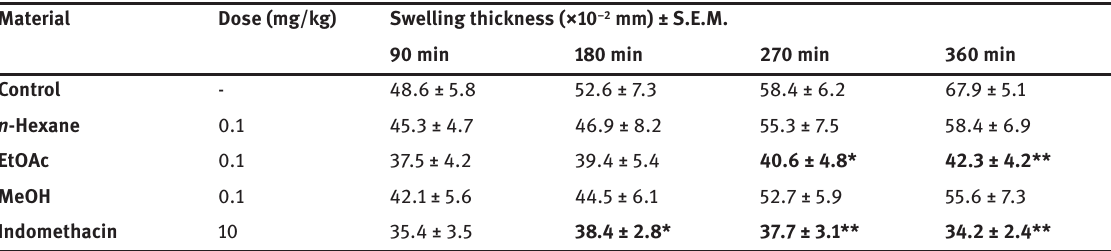
Table 1: Effects of test materials on carrageenan-induced hind paw edema in mice. Material